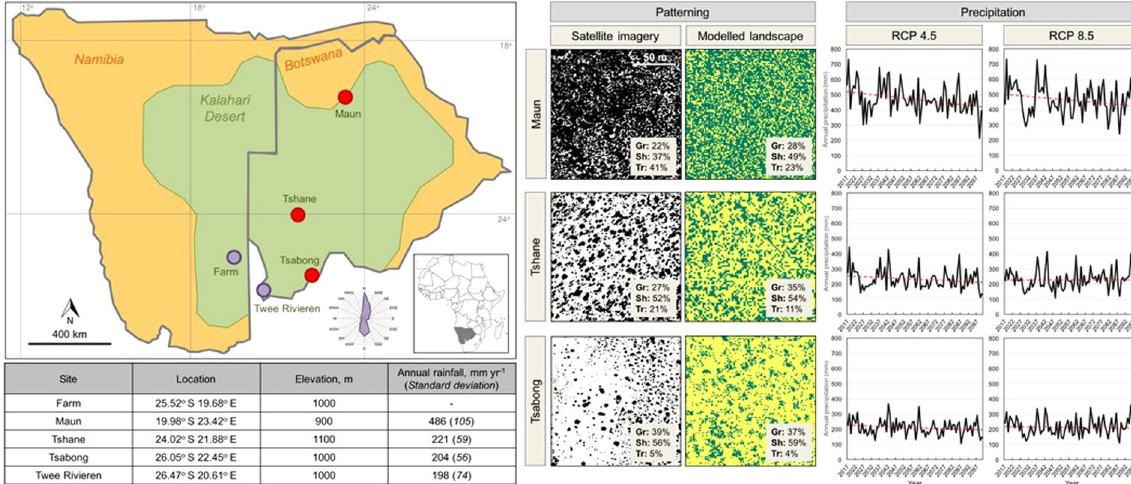
Figure 1. Map: Locations of experimental sites (main analysis sites shown as red dots, additional sites shown as purple dots). Green shaded area shows the extent of the Kalahari Desert in Botswana and Namibia. Wind rose shows aggregated mean monthly wind directions over the period Jan 1994–Dec 2013 at Twee Rivieren. Map was drawn digitally in MS Powerpoint (v.2010) by J.R. Mayaud, based on satellite data from Google Earth (v.5.1). Modelled vegetation states for the three study sites (for 2000, RCP 4.5) are compared to satellite imagery (Google Earth, v.5.1; converted to black (vegetation present) and white (bare surface) using a visually determined threshold). Proportions of vegetation types, both modelled and measured along vegetation transects near each site (see Supplementary Information for methods), are shown in inset grey boxes. Maun (19.99°S, 23.69°E) is located on the edge of the Okavango Delta, with a dominant grass/shrub system and some dense tree cover. Tshane (24.13°S, 22.04°E), in the middle of the Kalahari Desert, is characterised by lower cover of mixed grasses and shrubs, with occasional trees. Tsabong (26.04°S, 22.21°E) in southern Botswana also has low vegetation cover, mainly composed of grasses and shrubs with isolated trees. Graphs show projected over the period Jan 1984–Dec 2013 (standard deviations in brackets show interannual